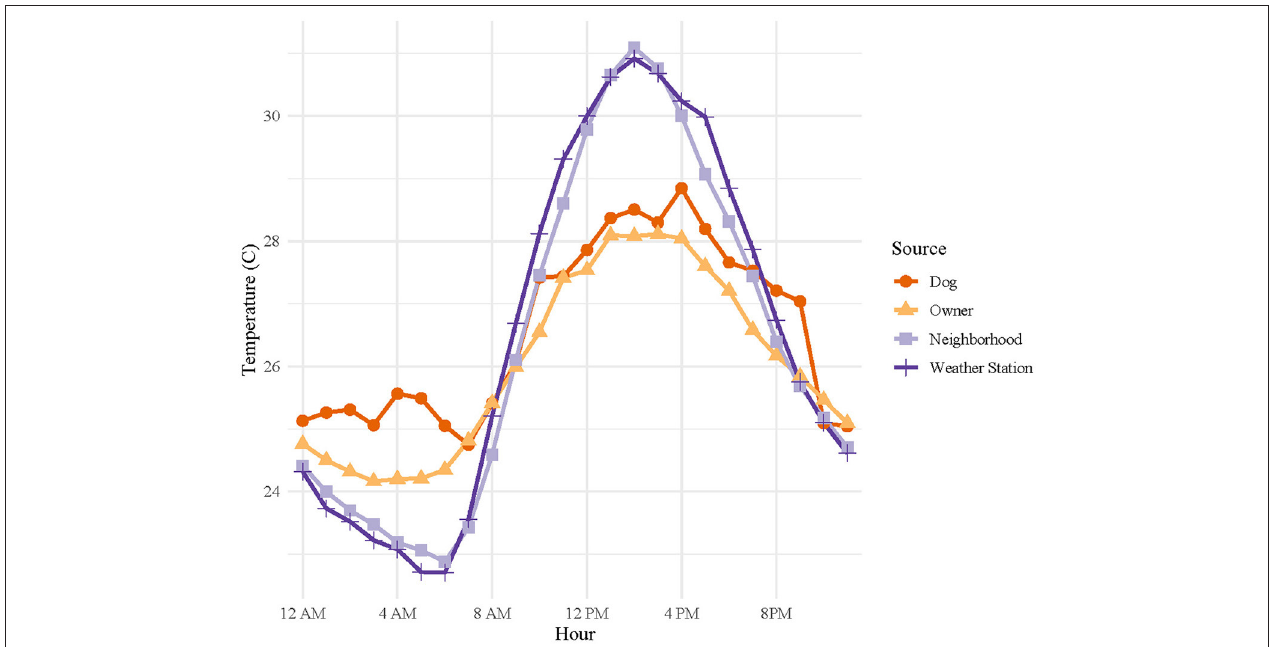
FIGURE 3 | Diurnal variation of mean hourly temperatures for all canine pets’ thermometers, owners’ thermometers, neighborhood thermometers, and nearest weather station. Canine pet and owner data were collected over a 6-day period for each dog, with staggered enrollment over a 10-day period in July 2017, using wearable iButton ® thermometers. Neighborhood ambient temperatures were captured using shielded iButton ® thermometers/hygrometers placed in neighborhoods and weather station data was downloaded from the National Weather Service weather station data archive.